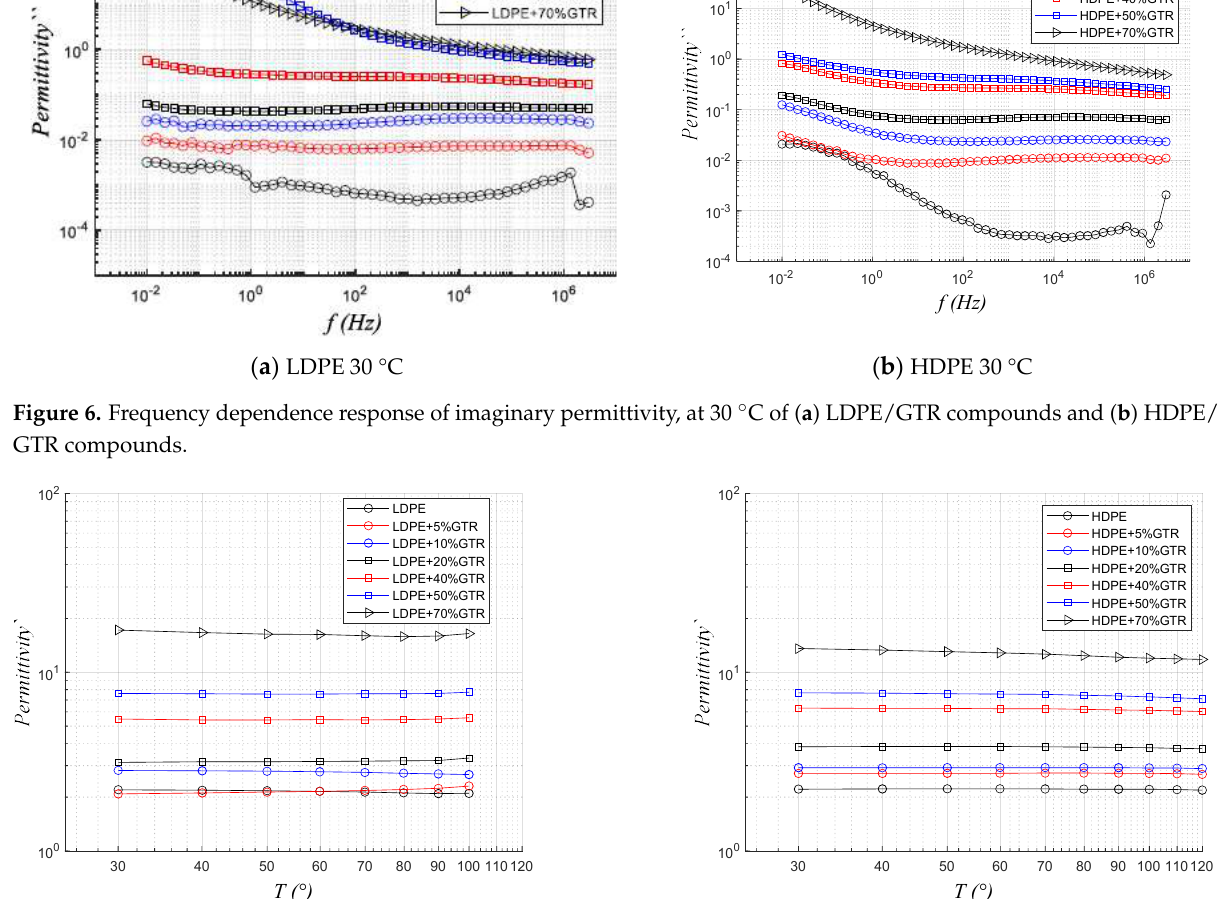
Figure 6. Frequency dependence response of imaginary permittivity, at 30 °C of ( a ) LDPE/GTR compounds and ( b ) HDPE/GTR compounds.